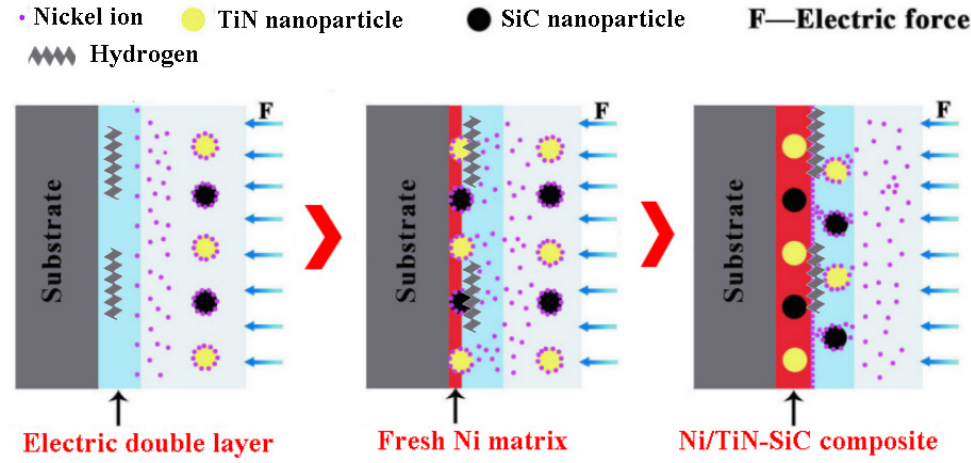
Figure 5. The mechanism of co-deposition for the nickel irons, SiC, and TiN nanoparticles. Pulse current density also had a significant effect on the distribution and amount of SiC and TiN nanoparticles embedded in Ni/TiN-SiC nanocomposites [22]. Equation (2) revealed the link between pulse current density and electric field